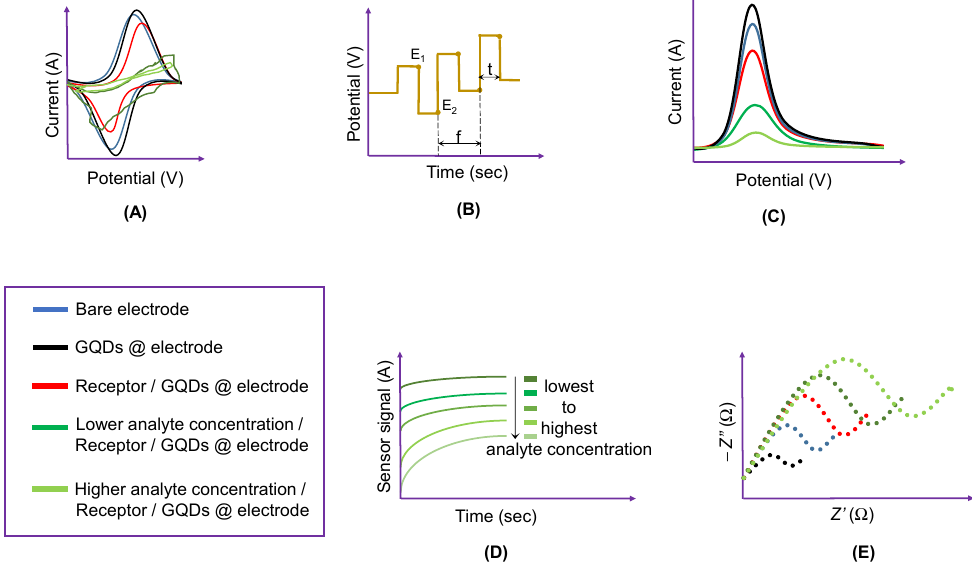
Figure 15. ( A ) Cyclic voltammetry (CV): potential vs. current profile with reference to a GQD-implanted electrode surface, where its electrochemical response changes according to the specific bio-recognition event. ( B ) Square wave voltammetry (SWV): potential vs. time profile, where t: time required for each pulse, f: frequency of each pulse, E 1 and E 2 : initial and final pulse, respectively. ( C ) Target biomolecule detection by GQD-coated electrode based on SWV, where the current changes in direct correlation with an occupancy of a specific receptor. ( D ) Ideal curves observed with amperometric measurements for varied concentrations of target biomolecules. ( E ) Electron impedance spectroscopy (EIS): variation